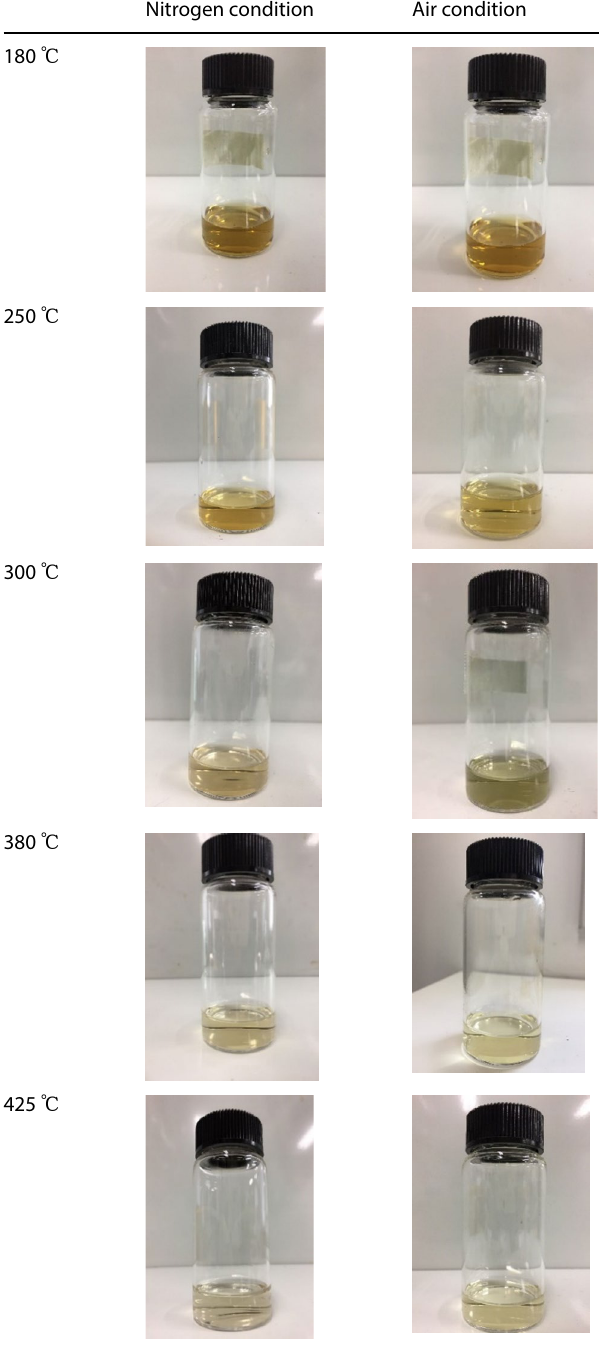
Table 2 Photographs of the liquid samples for each experiment Nitrogen